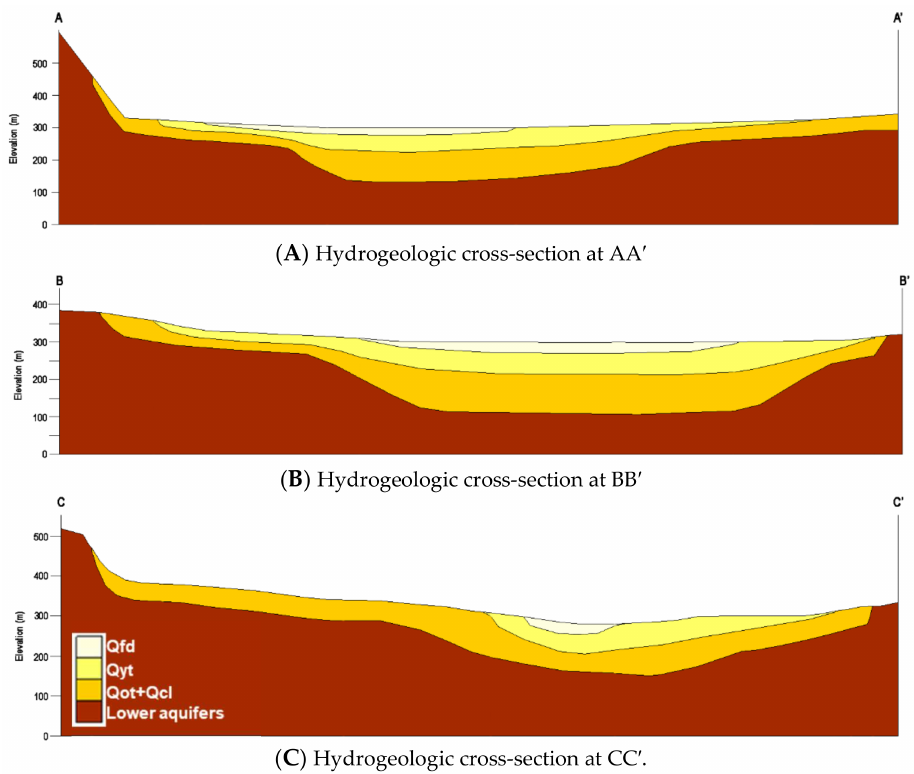
Figure 3. Hydrogeologic cross-sections of the unconsolidated aquifers (Q’s) in lines AA (cid:48) , BB (cid:48) , and CC (cid:48) . Note that, lower units are grouped into single semi- to consolidated